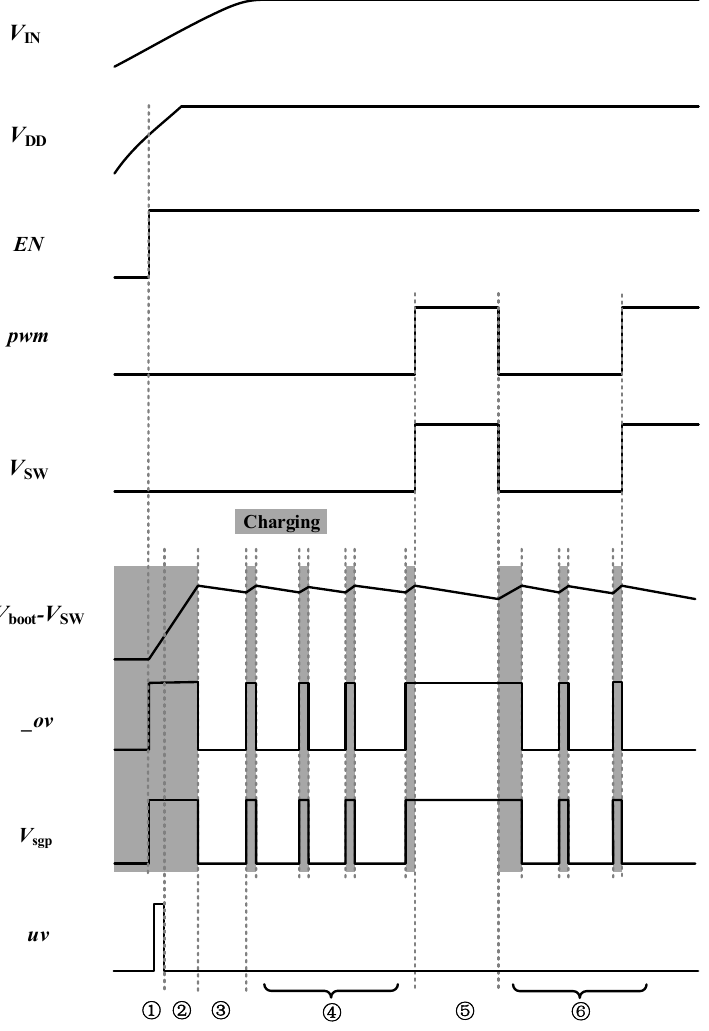
Figure 3. Working sequence of the proposed bootstrap structure.